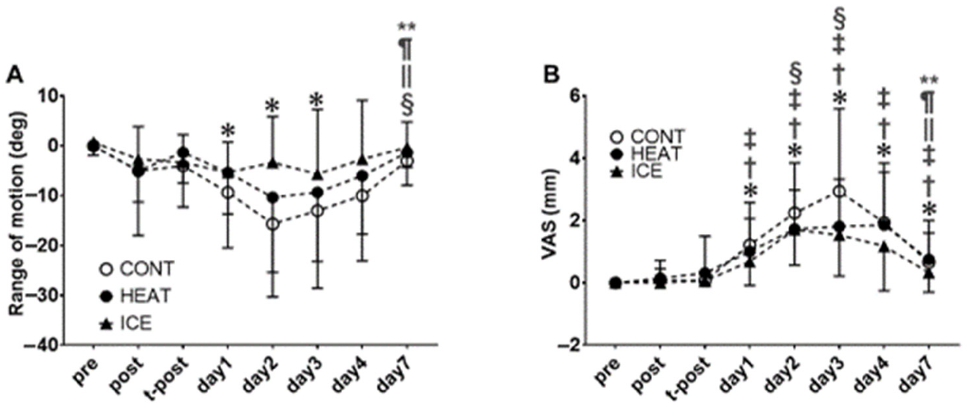
Figure 4. Changes in elbow extension range of motion ( A ) and muscle soreness at stretching by visual analog scale ( B ). * significant compared with pre ( p < 0.05); †, significant compared with post; ‡, significant compared with t-post; §, significant compared with day 1; ||, significant compared with day 2; ¶, significant compared with day 3; **, significant compared with day 4.